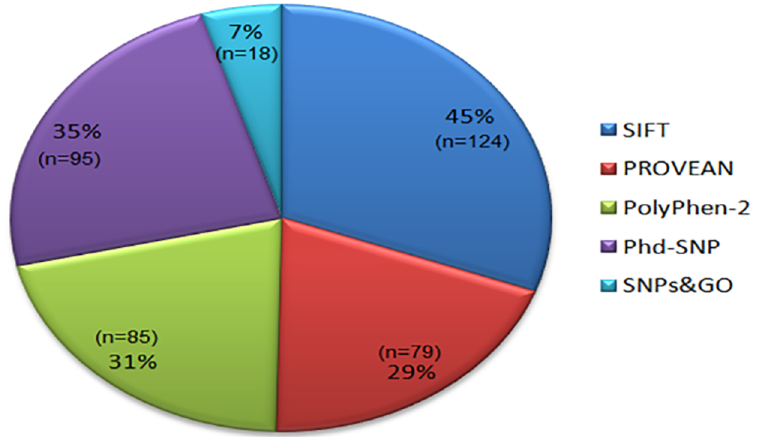
Fig 3. Pie chart showing percentage of damaging nsSNPs identified. The distributionof damaging nsSNPs by percentage(%) and number(n) identified by five in silico tools; SIFT, PROVEAN, PolyPhen-2, Phd-SNP and